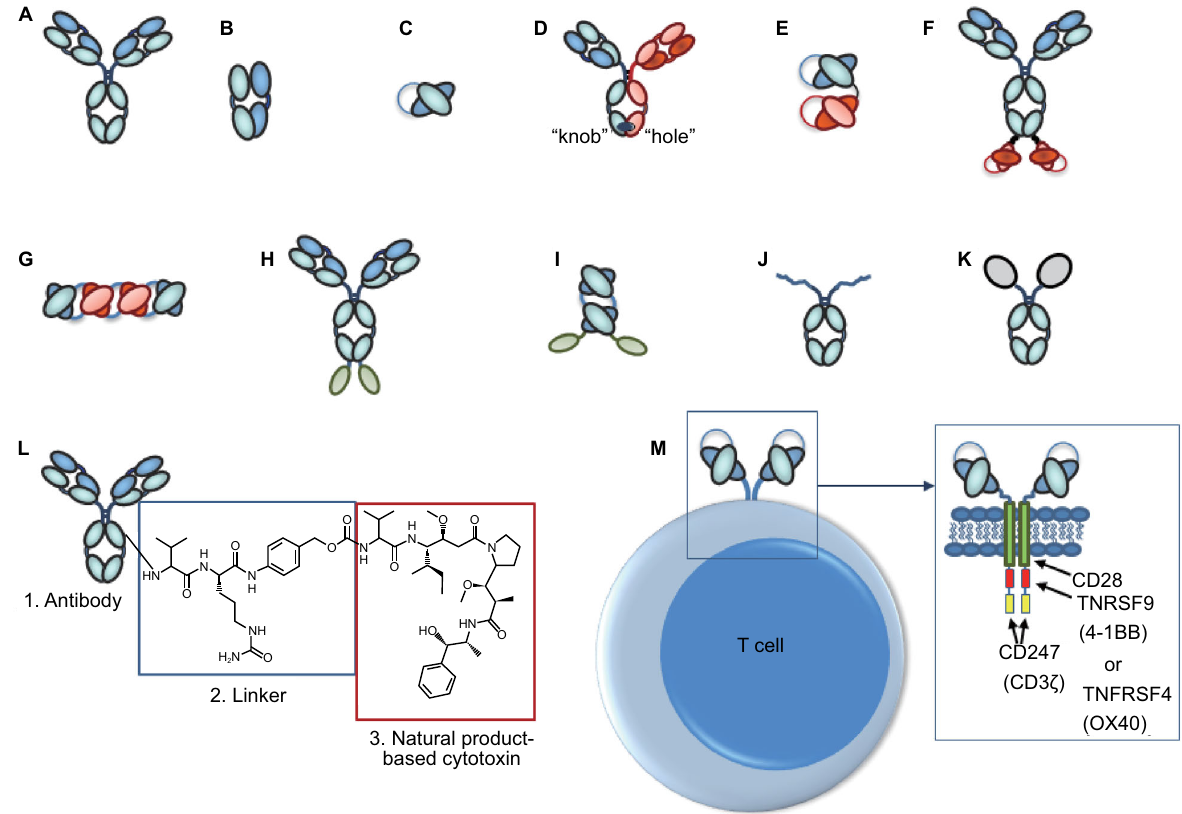
Figure 1. Cartoons of molecules and constructs discussed. (A) IgG monoclonal antibody; (B) FAb fragment; (C) Single chain fragment, variable (scFv); (D) Heterodimeric IgG-based bivalent, bispeci fi c antibody; (E) scFv-based bispeci fi c antibody such as a BiTE ( “ bispeci fi c T-cell engager ” ); (F) IgG-scFv-based tetravalent, bispeci fi c antibody; (G) Tetravalent scFv-based antibody called TandAb; (H) IgG-based Immunocytokine (cytokine is denoted by green oval); (I) Tandem scFv-immunocytokine (cytokine is denoted by green oval); (J) Fc-peptide fusion (peptides denoted by squiggled lines); (K) Fc-protein fusion (protein denoted by gray oval); (L) Antibody drug conjugate with three parts (antibody, linker, cytotoxic drug); (M) Chimeric antigen receptor (CAR)-T based antibody (scFvs on surface of recombinant T cell; examples of intracellular domains noted in